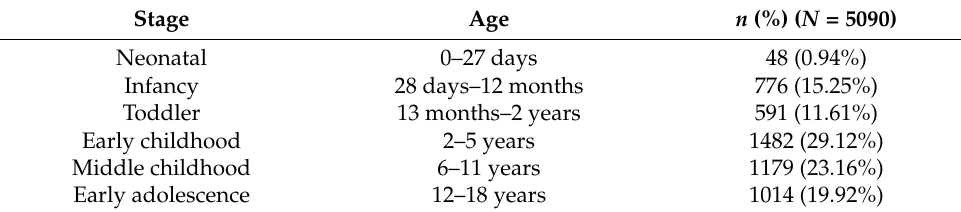
Abbreviations in the table: NICHD = National Institute of Child Health and Human